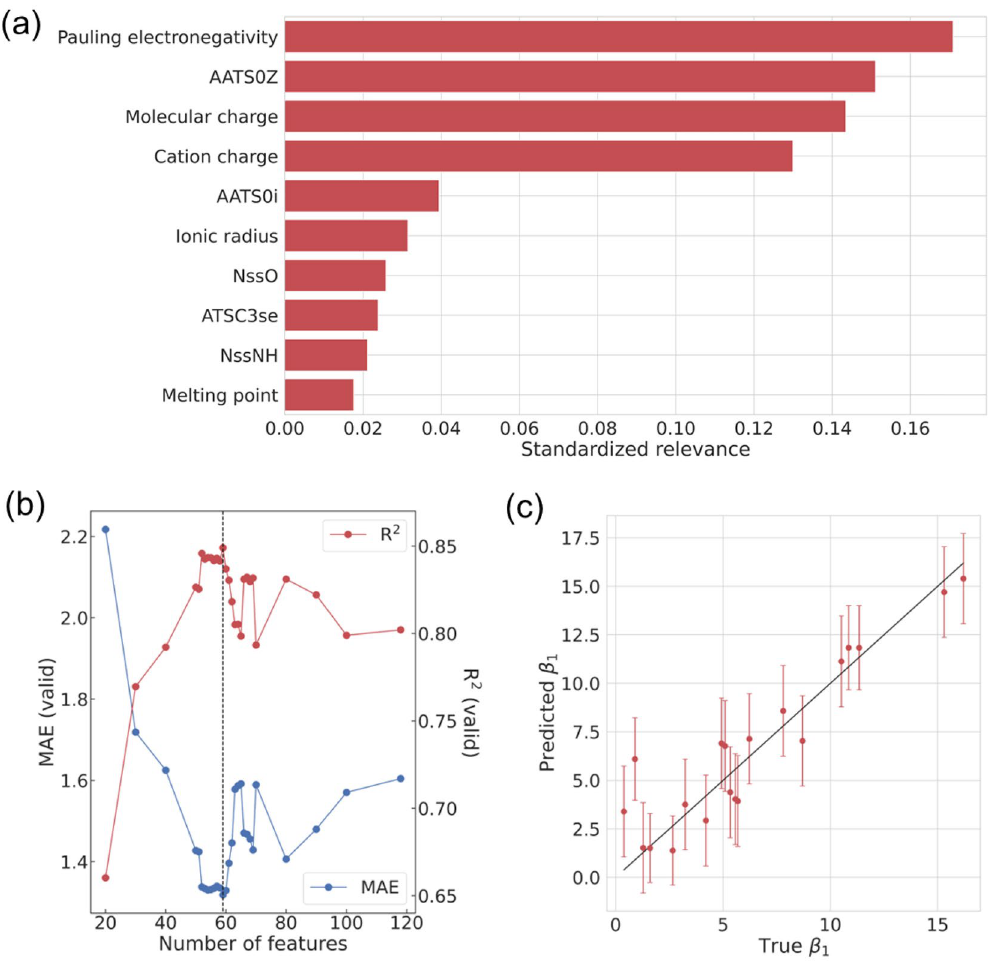
Figure 2. ( a ) The top 10 highest ranked features through sensitivity analysis using a Kullback–Leibler divergence as a measure for predicting β 1 . ( b ) Predictive performance for the validation samples as a function of the number of features. Features are arranged in descending order of relevance. The black dashed line corresponds to the top 59 features. ( c ) Parity plot between true and predicted β 1 values of the validation data using the best GPR model. Error bars indicate 1σ uncertainty of the predicted